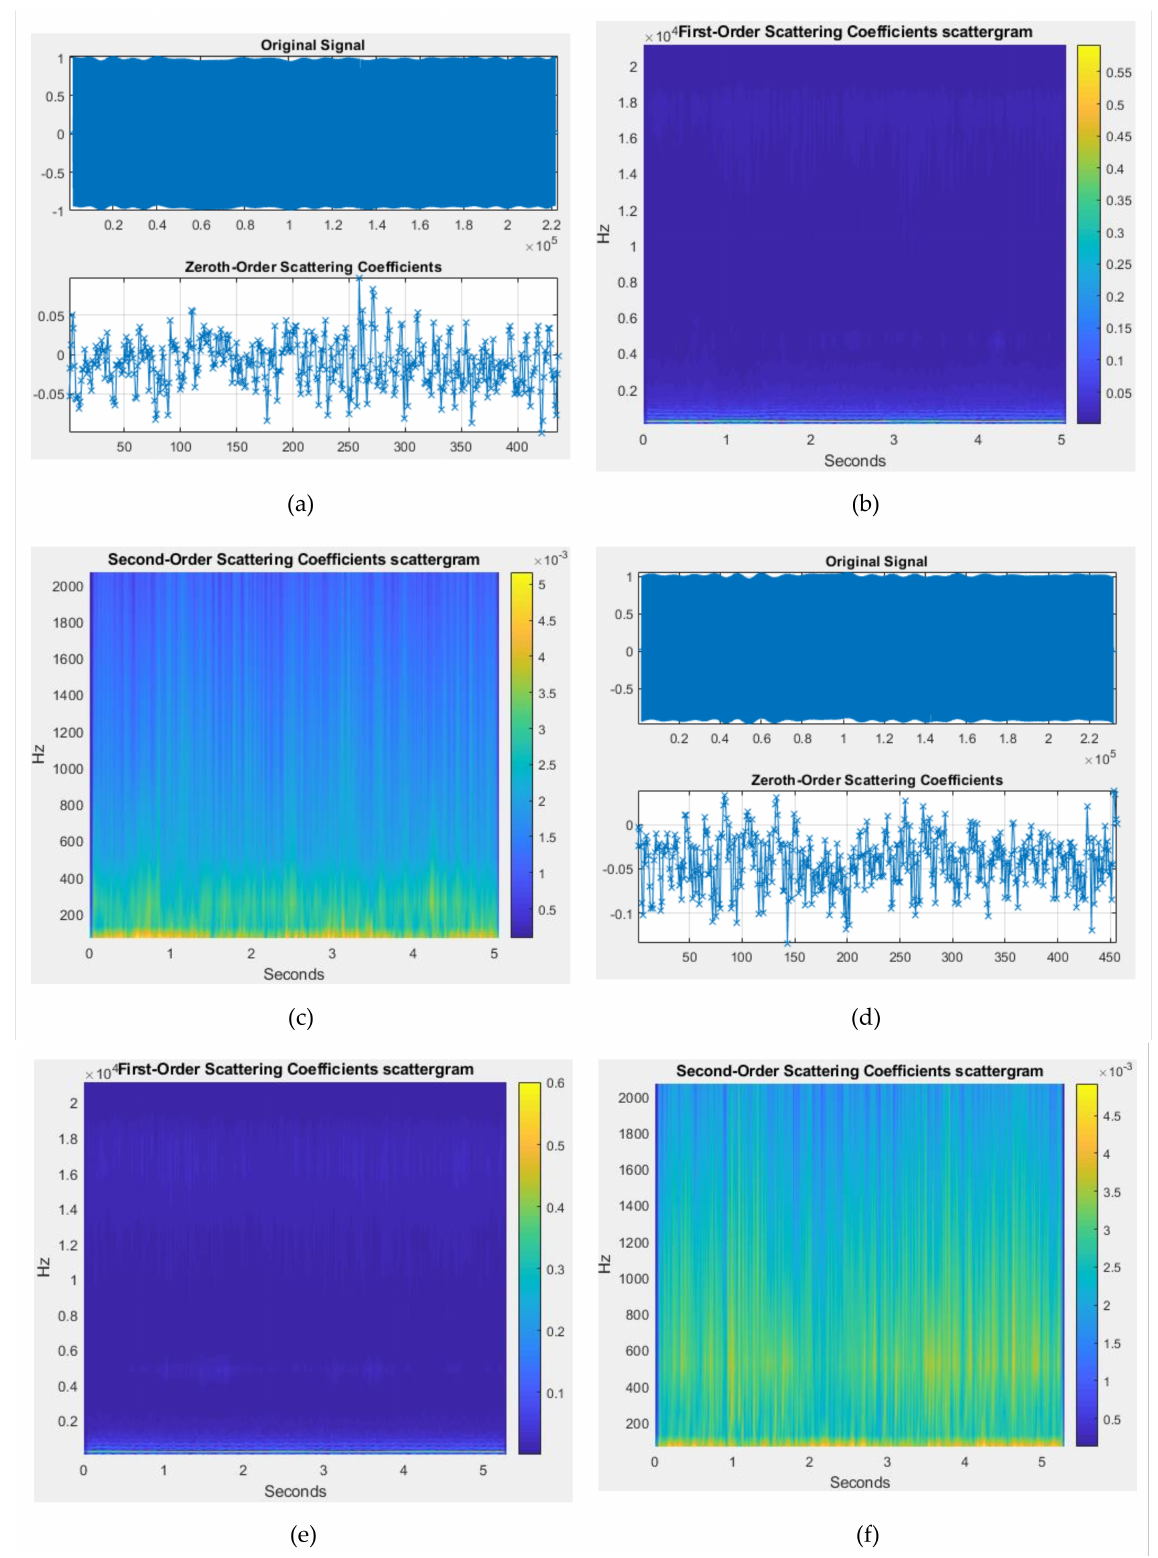
Figure 7. The wavelet scattering features of the damaged propeller: ( a ) original signal and zero-order scattering coefficients; ( b ) first-order scattering coefficients scattergram; ( c ) second-order scattering coefficients scattergram. The wavelet scattering features of the loosening of the motor screw: ( d ) original signal and zero-order scattering coefficients; ( e ) first-order scattering coefficients scattergram; ( f ) second-order scattering coefficients